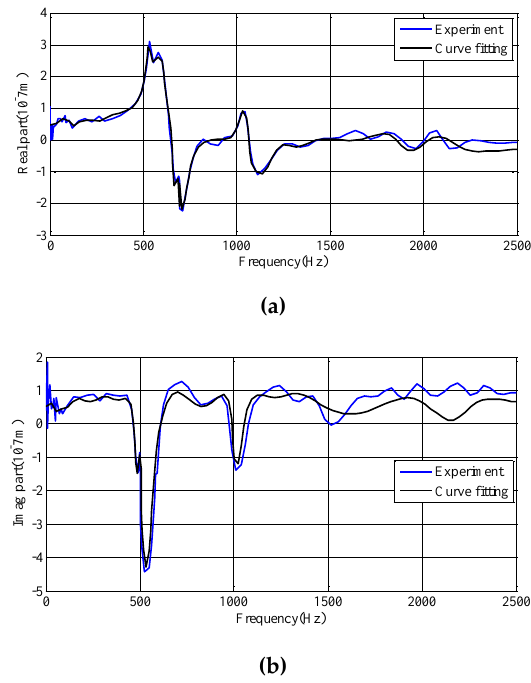
Figure 3. Fitting the measured frequency-response function. Table 1. The initial first-order modal parameters.